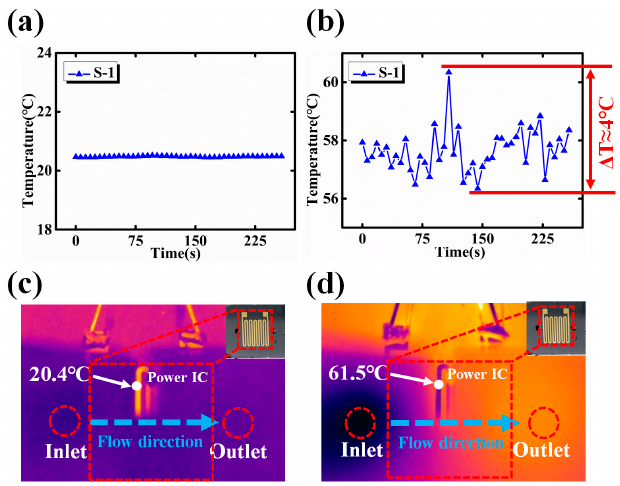
Figure 2. The temperature changes under the condition of ( a ) flow rate = 50 mL/h, input power = 0 W; ( b ) flow rate = 50 mL/h, input power = 4.2 W. Corresponding photographs of IR camera under the condition of ( c ) flow rate = 50 mL/h, input power = 0 W; ( d ) flow rate = 50 ml/h, input power = 4.2 W.